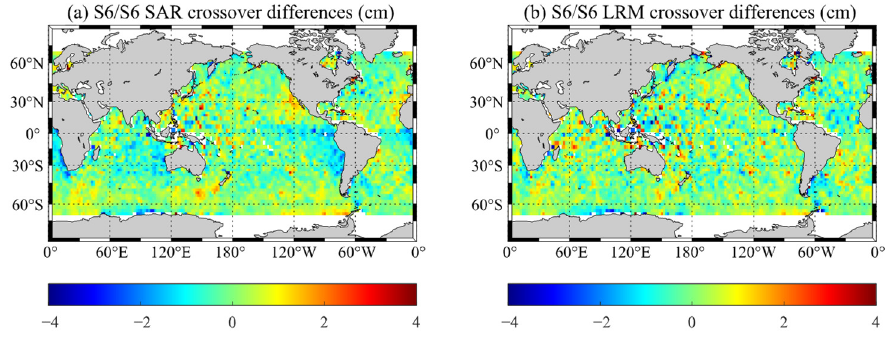
Figure 4. Maps of Sentinel-6 SSH crossover differences for ( a ) SARM and ( b ) LRM from November 2021 to October 2022 (Cycle 37 to Cycle 71).